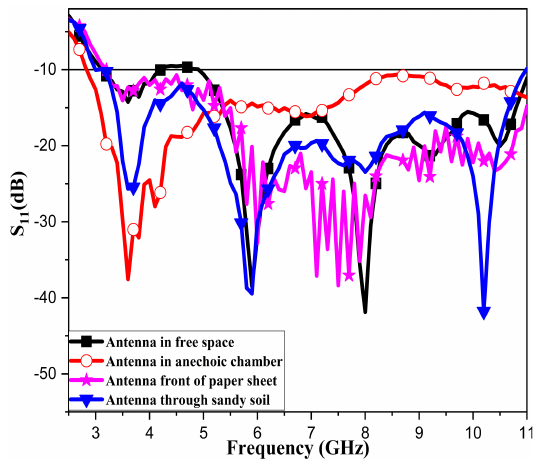
FIGURE 16. Comparison of the S 11 through different